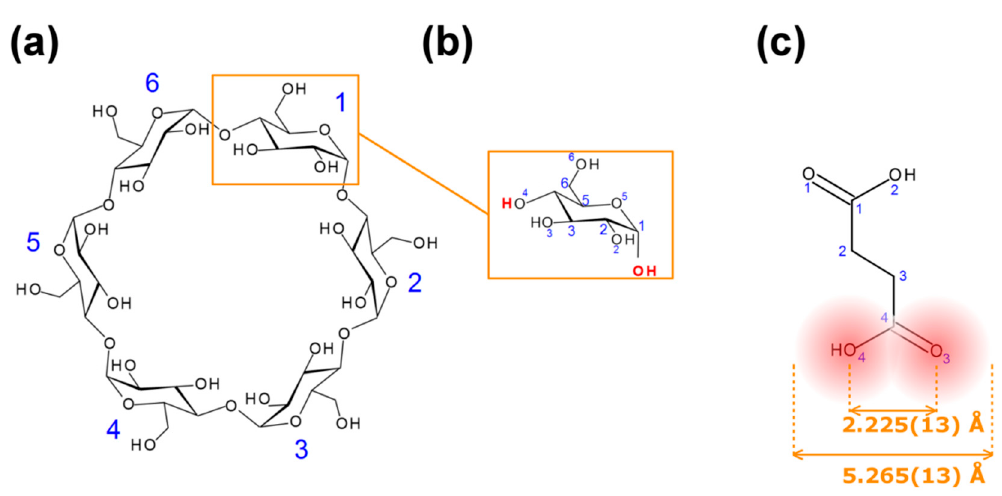
Figure 1. Diagrams and numbering schemes of: ( a ) α -cyclodextrins; ( b ) α -D-glucopyranose; ( c ) succinic acid (SA): the mean distance O(3)–O(4) was computed from 72 structures of SA in the Cambridge Structural Database (CSD), the width of SA is the (mean distance O(3)–O(4) plus twice the van der Waals radius of an oxygen atom.